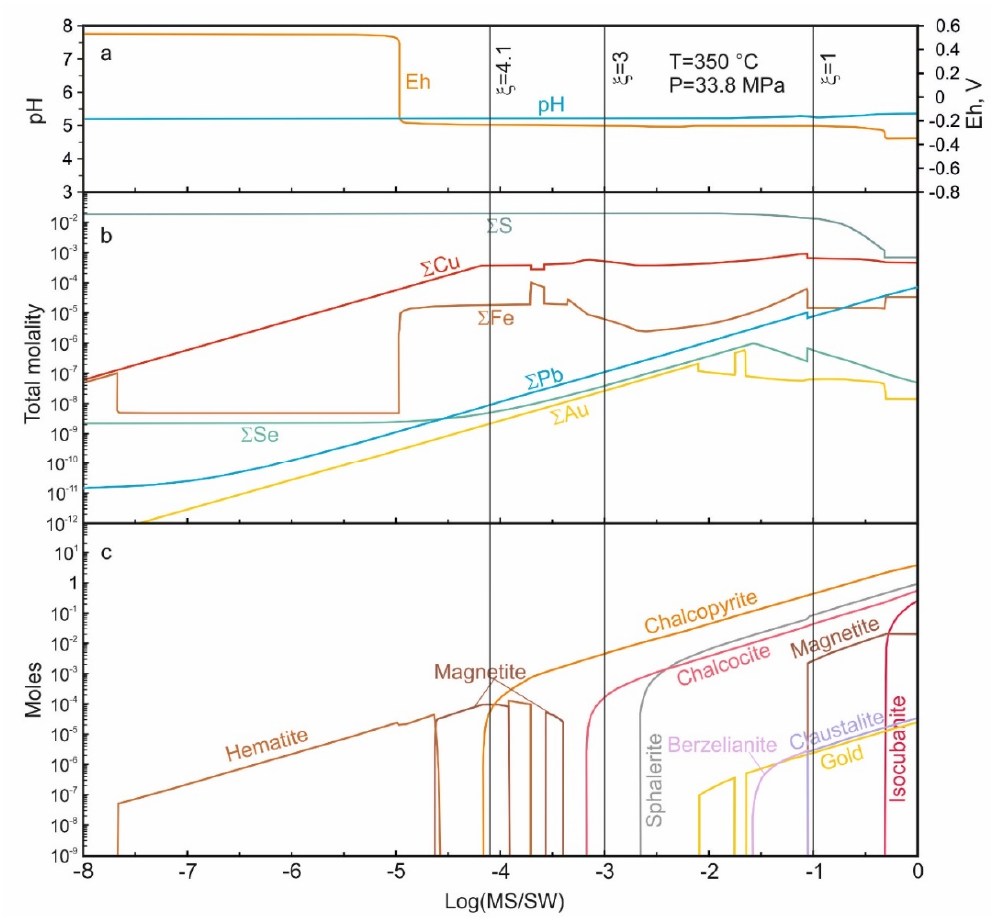
Figure 6. Calculated pH ( a ) element content in solution ( b ) and mineral assemblages ( c ) precipitated as a result of massive sulfides/seawater (MS/SW) interaction. Vertical lines corresponds to ξ values (–log 10 (MS/SW)), for which mineral assemblages at conductive cooling are calculated (see figures below).